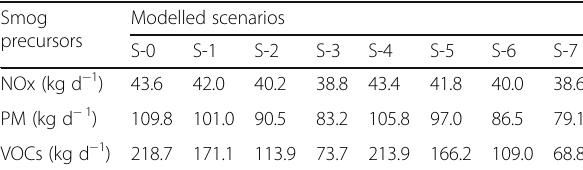
Table 6 Emission of smog precursors in total waste